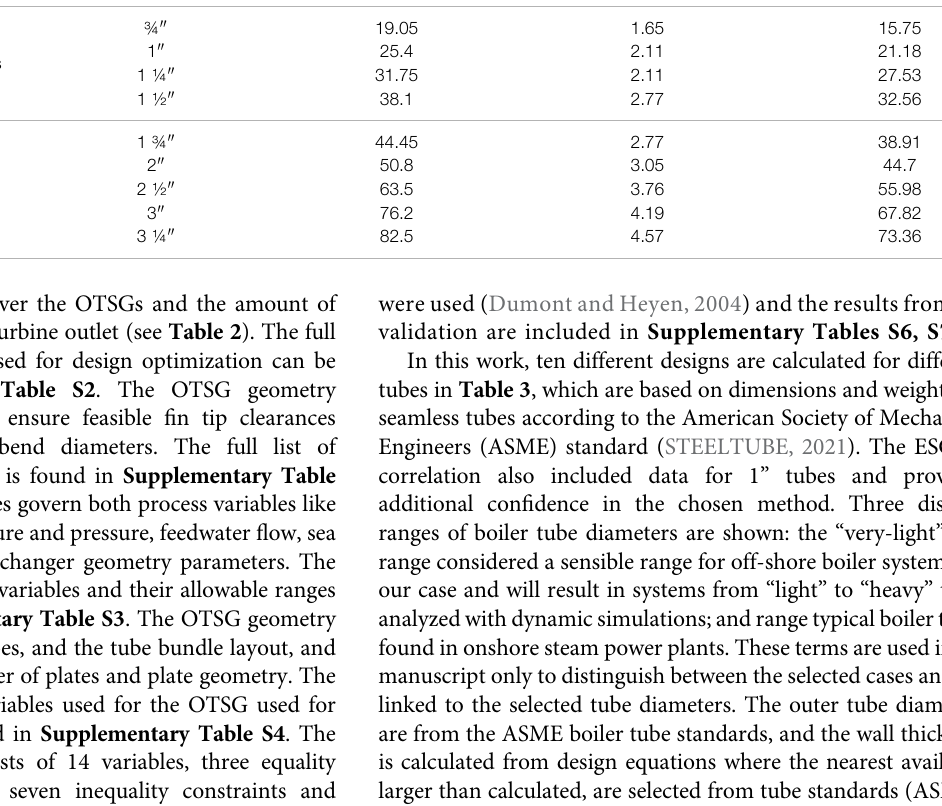
TABLE 3 | A selection of boiler tube diameters and wall thicknesses: seamless tubes according to the ASME standard (STEELTUBE 2021). Outer diameter ( 0 ) Outer diameter (mm) Wall thickness (mm) Very light ½